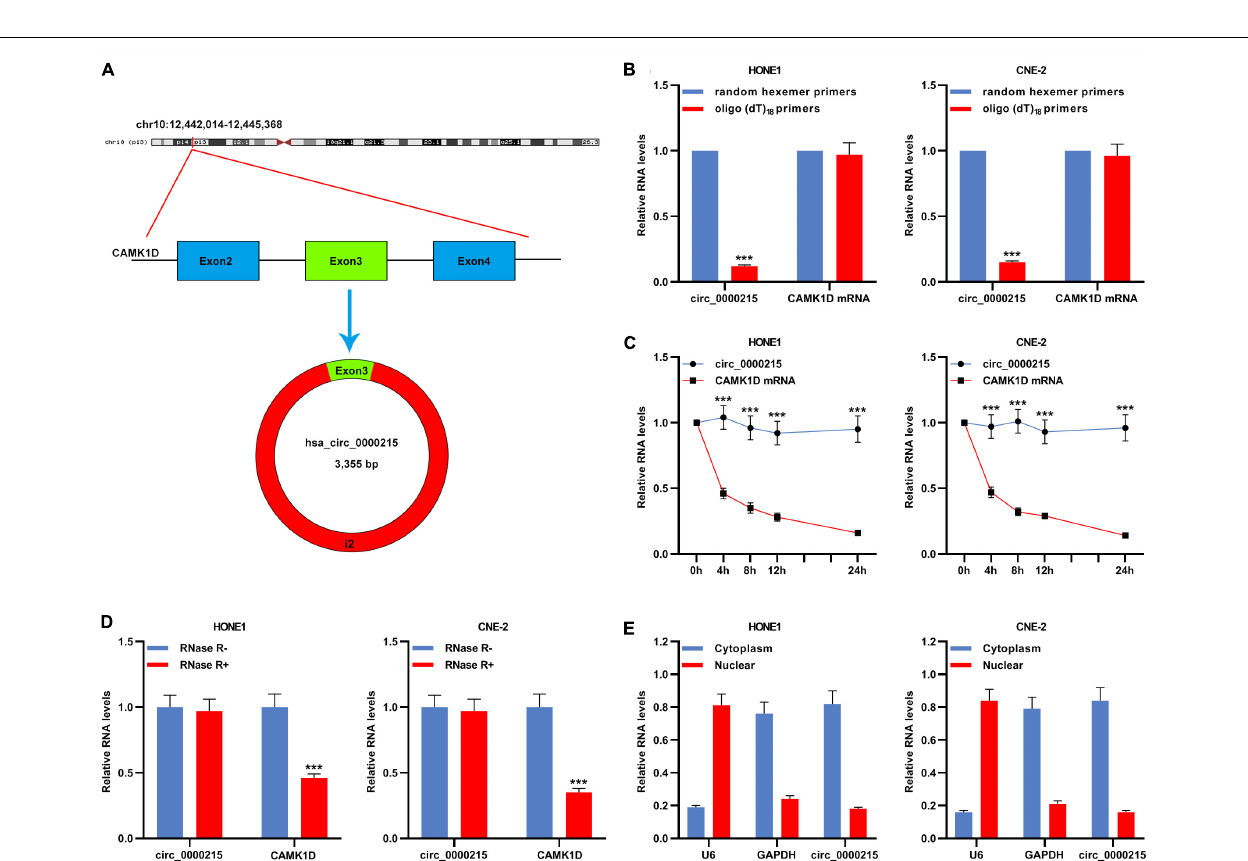
FIGURE 2 | Characterization of circ_0000215. (A) The schematic diagram illustrated the production of circ_0000215. (B) Reverse transcription was carried out using random hexamer or oligo (dT) 18 primers. Then qRT-PCR was performed to detect the relative expression levels of circ_0000215 and CAMK1D mRNA. (C) qRT-PCR was executed to detect the relative expression levels of circ_0000215 and CAMK1D mRNA after HONE1 and CNE-2 cells were treated with actinomycin D. (D) qRT-PCR was performed to detect the enrichment of circ_0000215 and CAMK1D after the total RNA was incubated with or without RNase R. (E) The relative expression level of circ_0000215 in the cytoplasm and nucleus of HONE1 and CNE-2 cells was detected by qRT-PCR, and GAPDH and U6 were used as positive controls of the cytoplasm and nucleus, respectively. The significance of difference was determined by Student’s t -test. *** P < 0.001. Data from three independent experiments were expressed as mean ± standard